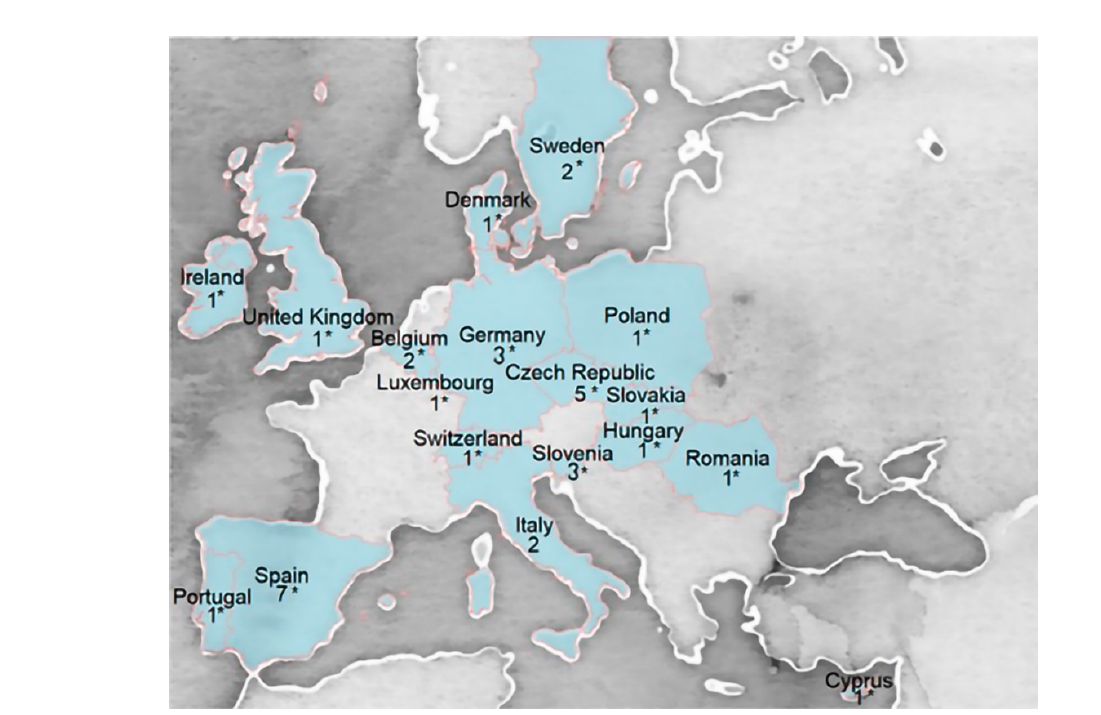
Figure 1. Distribution of European HBM studies included in the MeHg risk assessment. * Indicates countries included in the DEMOCOPHES study. Numbers in the figure indicate the number of studies in each country.